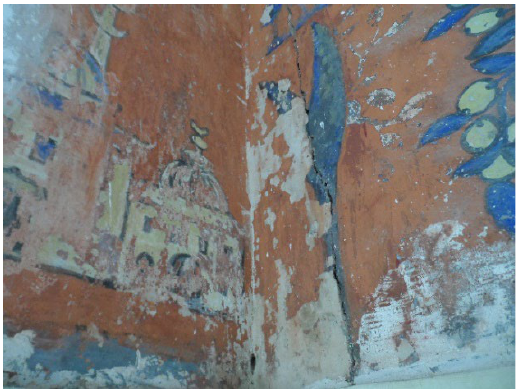
Figure 4. Un-enhanced image of mural painting of Haj Ahmed palace.